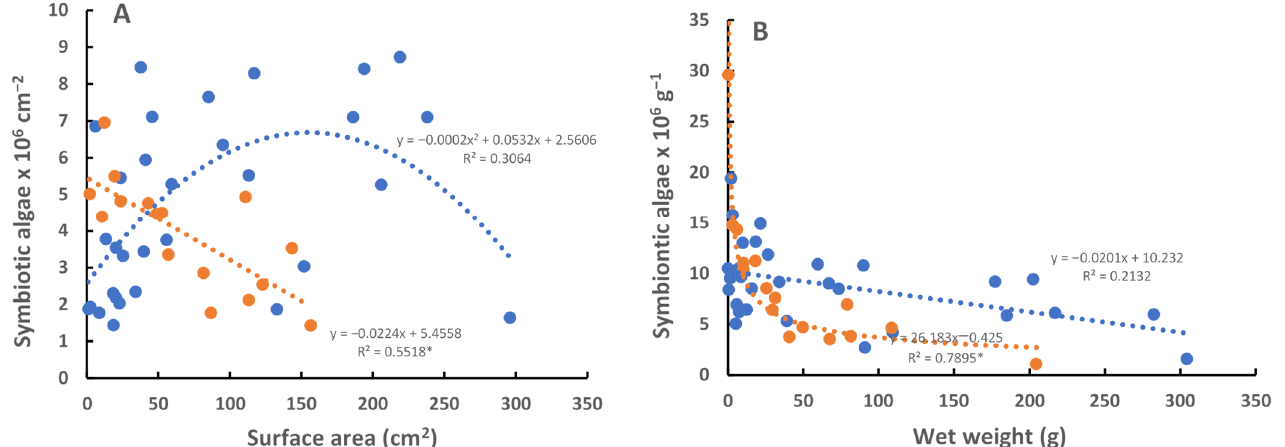
Figure 3. Number of symbiotic algae in the medusae of C. frondosa (blue, n = 30) and C. xamachana (red, n = 16): ( A ) per cm 2 of the bell surface area, ( B ) per gram of wet weight. Regressions with * are significant ( p < 0.05). Number of symbionts per amebocyte was similar in C. xamachana (6.66 ± 3.68, n = 5)